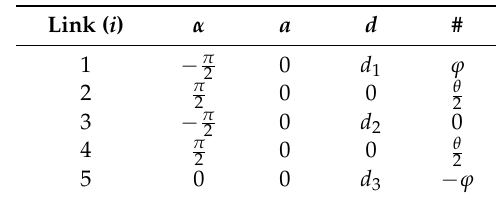
Table 1. Denavit–Hartenberg (D–H) parameters of the single SIMBA arm module.